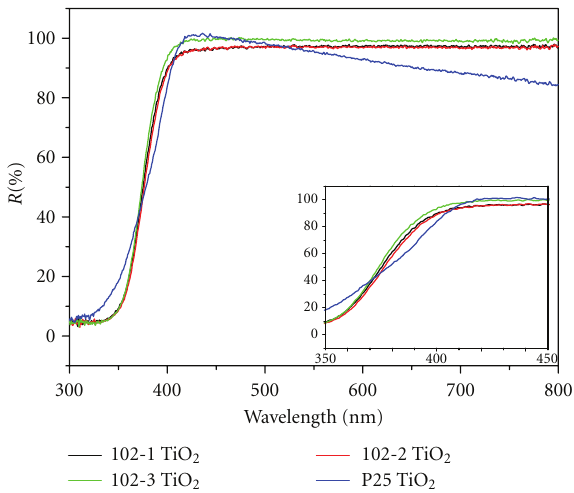
Figure 4: UV-visible di ff use reflection spectra of TiO 2 . The inset shows an enlarged UV-Visible di ff use reflection spectra between 350 and 450 nm.